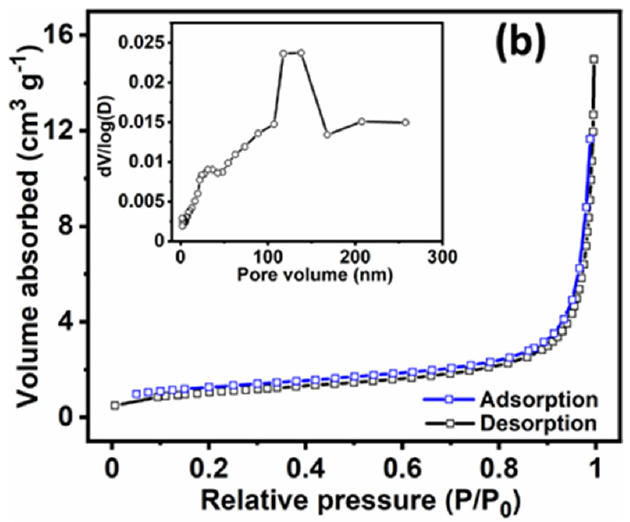
Figure 4. Nitrogen adsorption-desorption isotherms analysis and the inset shows corresponding pore size distribution, ( a ) pristine FNS and ( b ) FNS@GC.